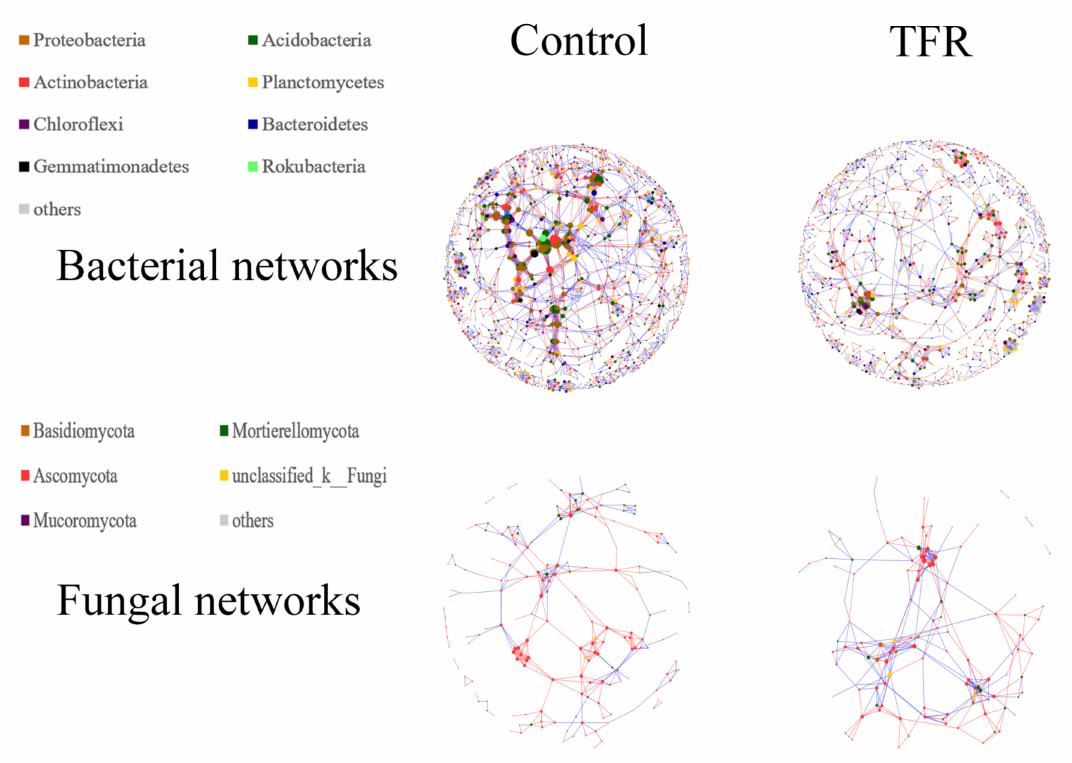
Figure 4. Bacterial and fungal networks under control and TFR treatment. Node size is proportional to the node degree. Nodes are colored for bacterial and fungal phyla with relative abundance >1%, and those <1% are shown in grey. Red and blue edges indicate positive and negative correlations,